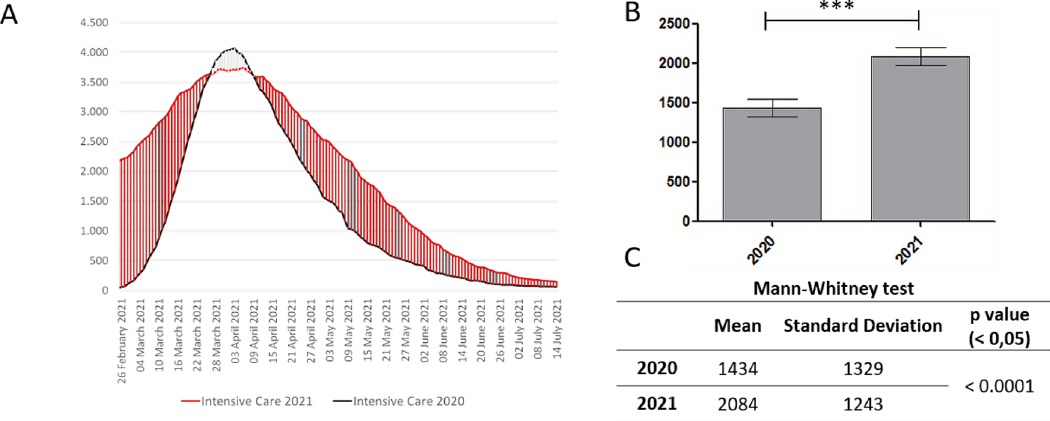
Figure 3. A. Trend of the Intensive care unit variable; B. Significant differences between two periods, with *p < .05; C. Mean, Standard deviation, p